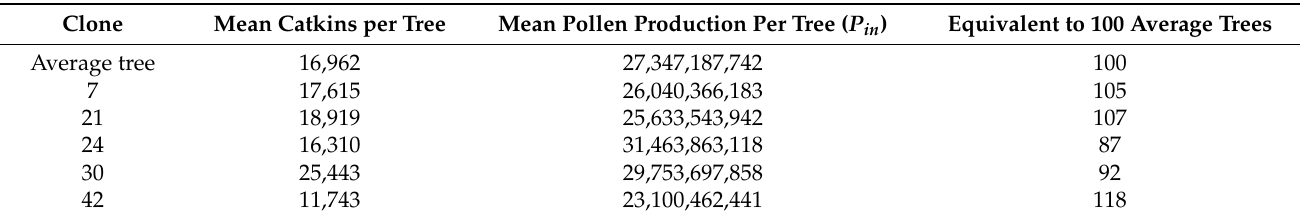
Table 6. Mean number of catkins and mean pollen production for different clones and for an average tree. The last column shows the equivalence of the selected clones’ trees to an average